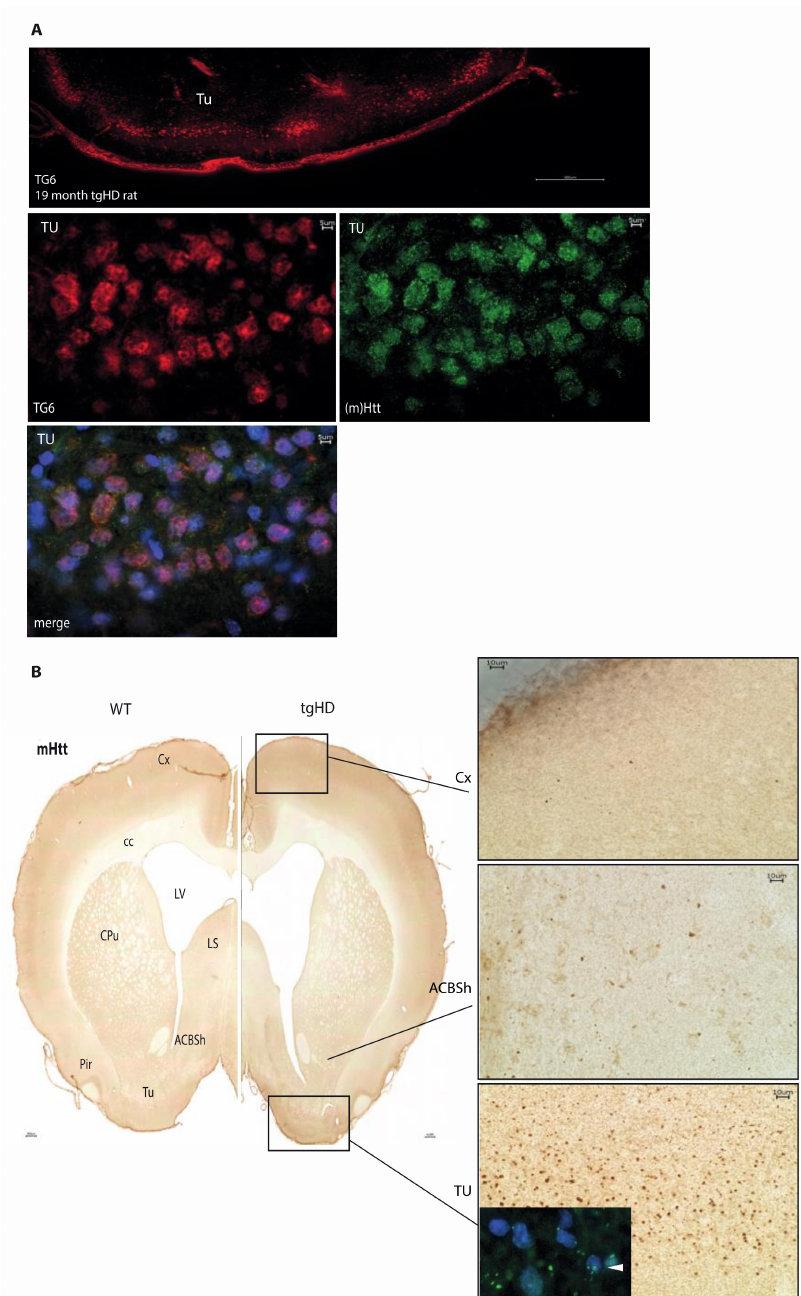
Figure 3. Regional colocalization of TG6 and mHTT aggregates in the brain of tgHD rats ( A ) Im- munofluorescent double labeling of TG6 (red) and HTT (green) clearly shows that the two proteins are localized in the same cells, e.g., in the olfactory tubercle (TU). Colocalization was analyzed using a huntingtin- and TG6-specific antibody (EP867Y for HTT, polyclonal goat anti-TG6, both 1:500). Scale bars: 5, 300 µ m. ( B ) S830-immunopositive mHTT aggregates display a defined regional distribution pattern. Overview sections of 19-month-old tgHD rats compared to their wt littermates. Areas such as the cortex (Cx), the shell of the nucleus accumbens (ACBSh), the olfactory tubercle (Tu) and the piriform cortex (Pir) are prominent for S830-positive mHTT aggregates (overview section on the left). No staining was found in wt animals. At a higher magnification, S830 immunoreaction products appear as dark or green fluorescent structures, varying in size and form, in the nuclei and cytoplasm (Immunohistochemistry and immunofluorescence images shown in the right panel as indicated by white arrowhead in the inlay). Counterstaining was done using DAPI. Scale bars: 5, 10 and 300 µ